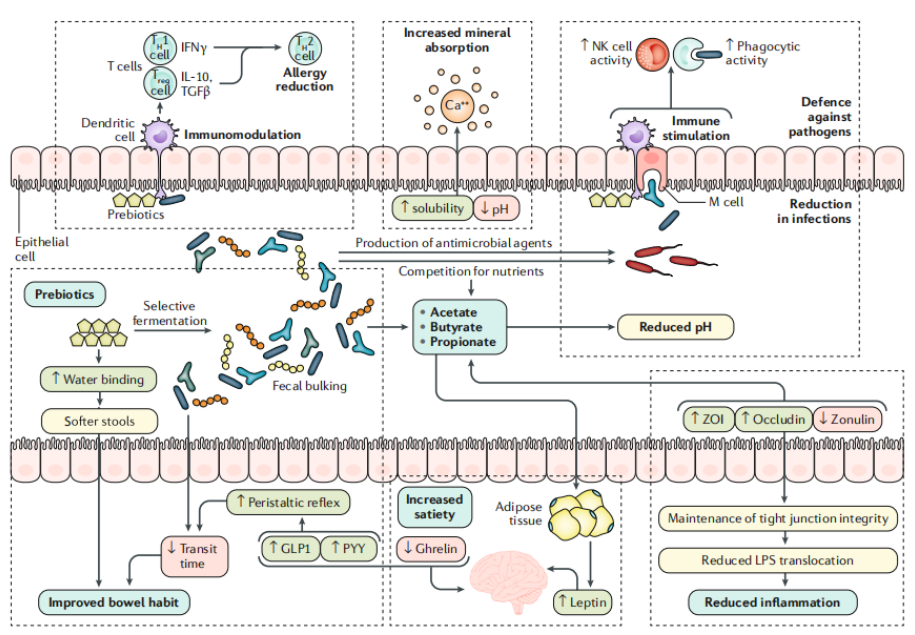
Figure 2. Prebiotic mechanism of